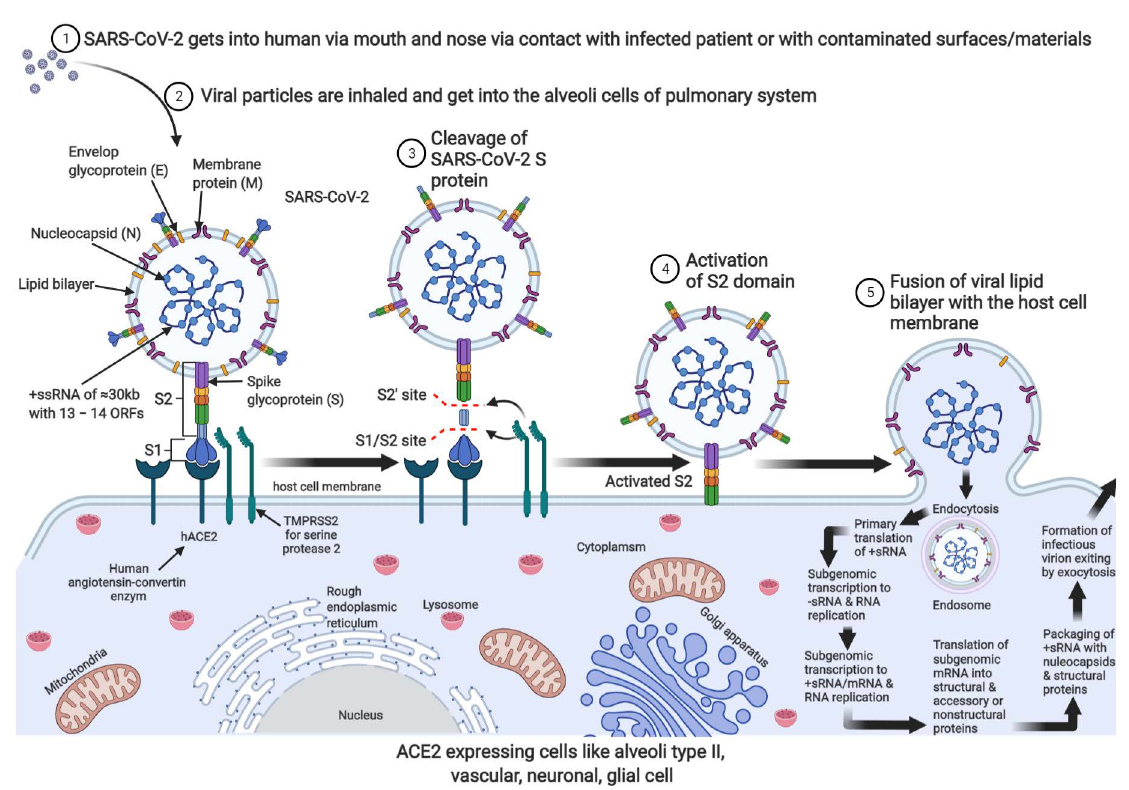
Figure 1. Mechanism of SARS-CoV-2 viral entry, endocytosis, translation, replication, viral packaging, and exocytosis in ACE2-expressing cells. A complete infectious SARS-CoV-2 is +ssRNA enclosed nucleocapsid surrounded by a lipid bilayer that harbours envelop glycoprotein, a membrane protein with protruding crownlike spike protein, which binds the membrane-located ACE2 enzyme that facilitates proteolytic cleavage of S-protein on the viral particle (2–3). Activated S-protein induces invagination of the host cell membrane leading to endocytic movement of the viral particle (4–5). The endosome is degraded with the help of lysosomal cathepsin L/B to release the viral genome for primary translation to produce the RNA-dependent RNA polymerase (RdRp complex). The polymerase transcribes the +sRNA to sub-genomic s–RNA and subsequently full-length +sRNA and some sub-genomic mRNAs that are translated by the host cell ribosomal machinery into nucleocapsid structural and accessory protein. Successful translation, transcription, and RNA replication lead to viral packaging, and the infectious virion can leave the cell by exocytosis to infect the next